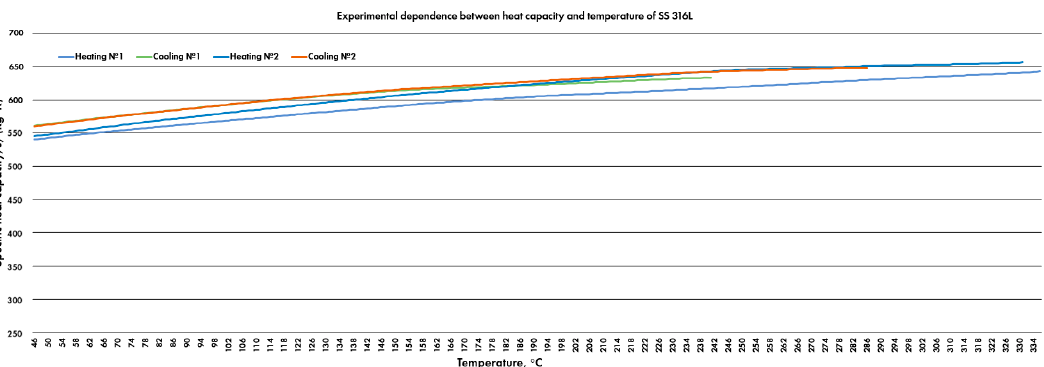
Figure 4. DSC curves of commercially pure SS 316L measured during 4 cycles. Measurement pre- cision was ± 2.5%.